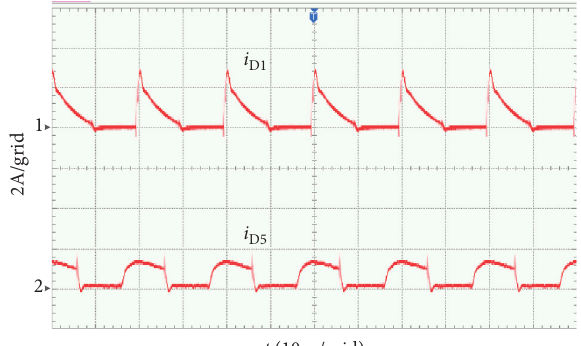
Figure 20: Waveform of i